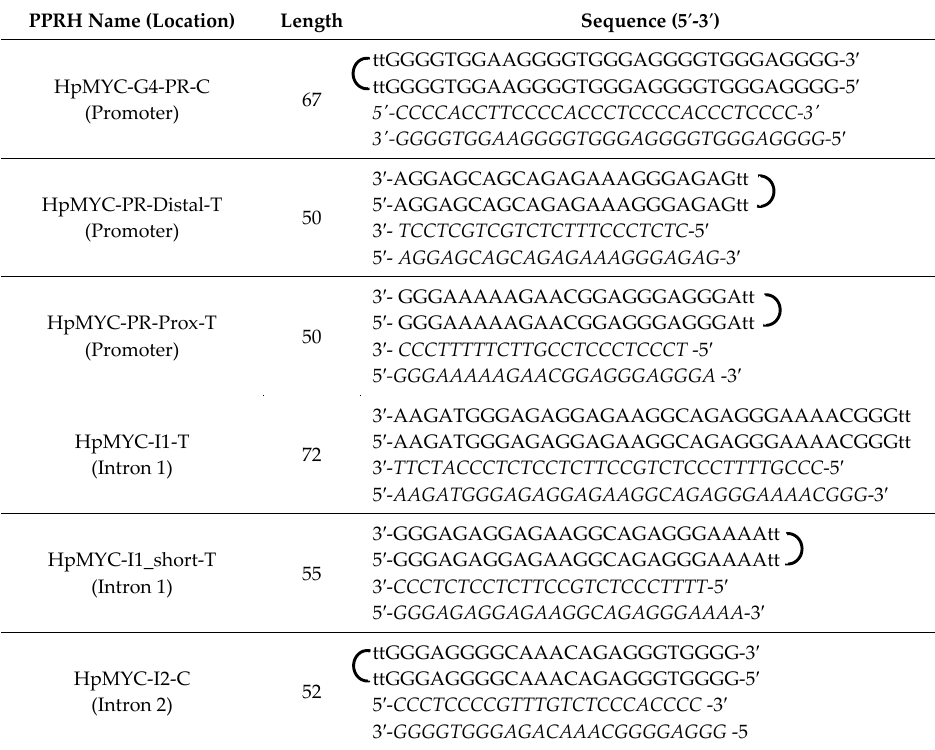
Table 3. Design of MYC-targeting PPRHs with their target sequences in italics.